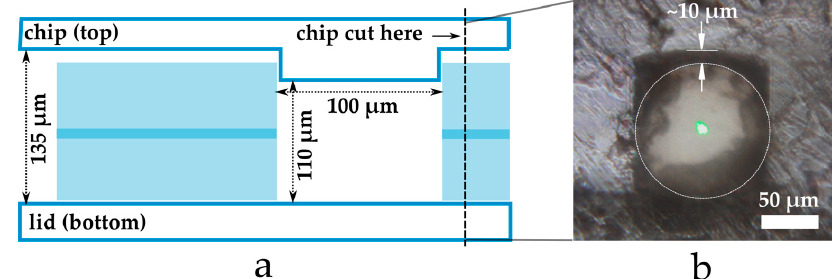
Figure 3. Effect of lid bonding on assembled chip: ( a ) Design of an assembled chip; ( b ) cross-section of assembled chip including single mode fiber fixed within the fiber groove, transmitting green laser light. The outline of the fiber has been enhanced to make it visible.